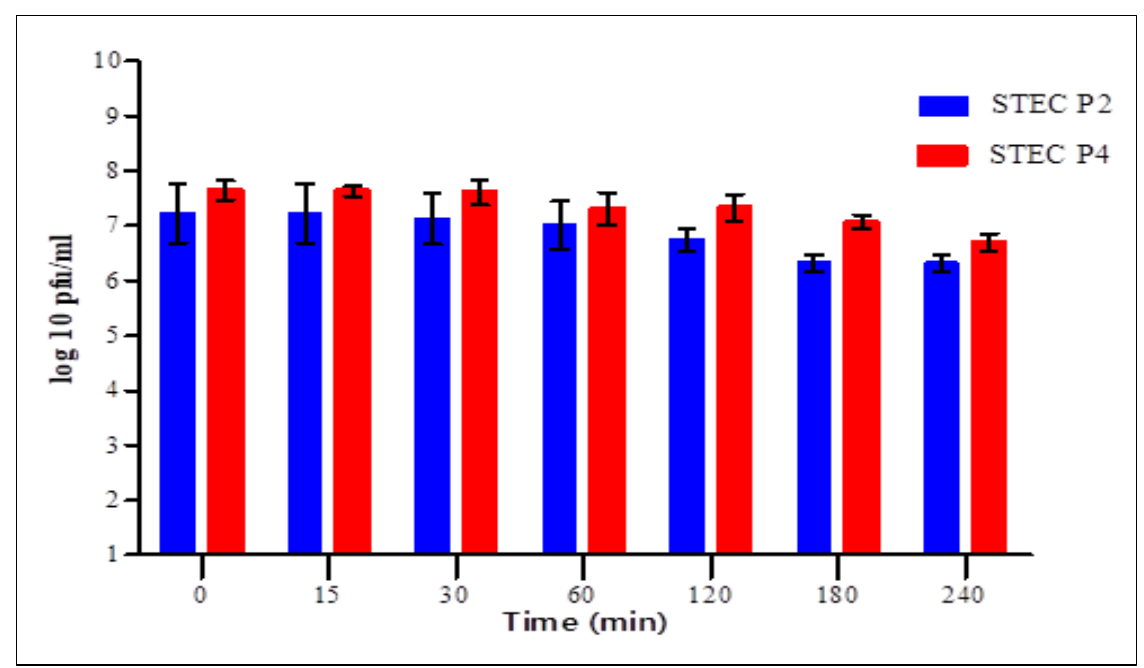
Figure 7. Effect of simulated gastric fluid on the counts of STEC P2 and STEC P4. LSD value at 0.05:0.286.